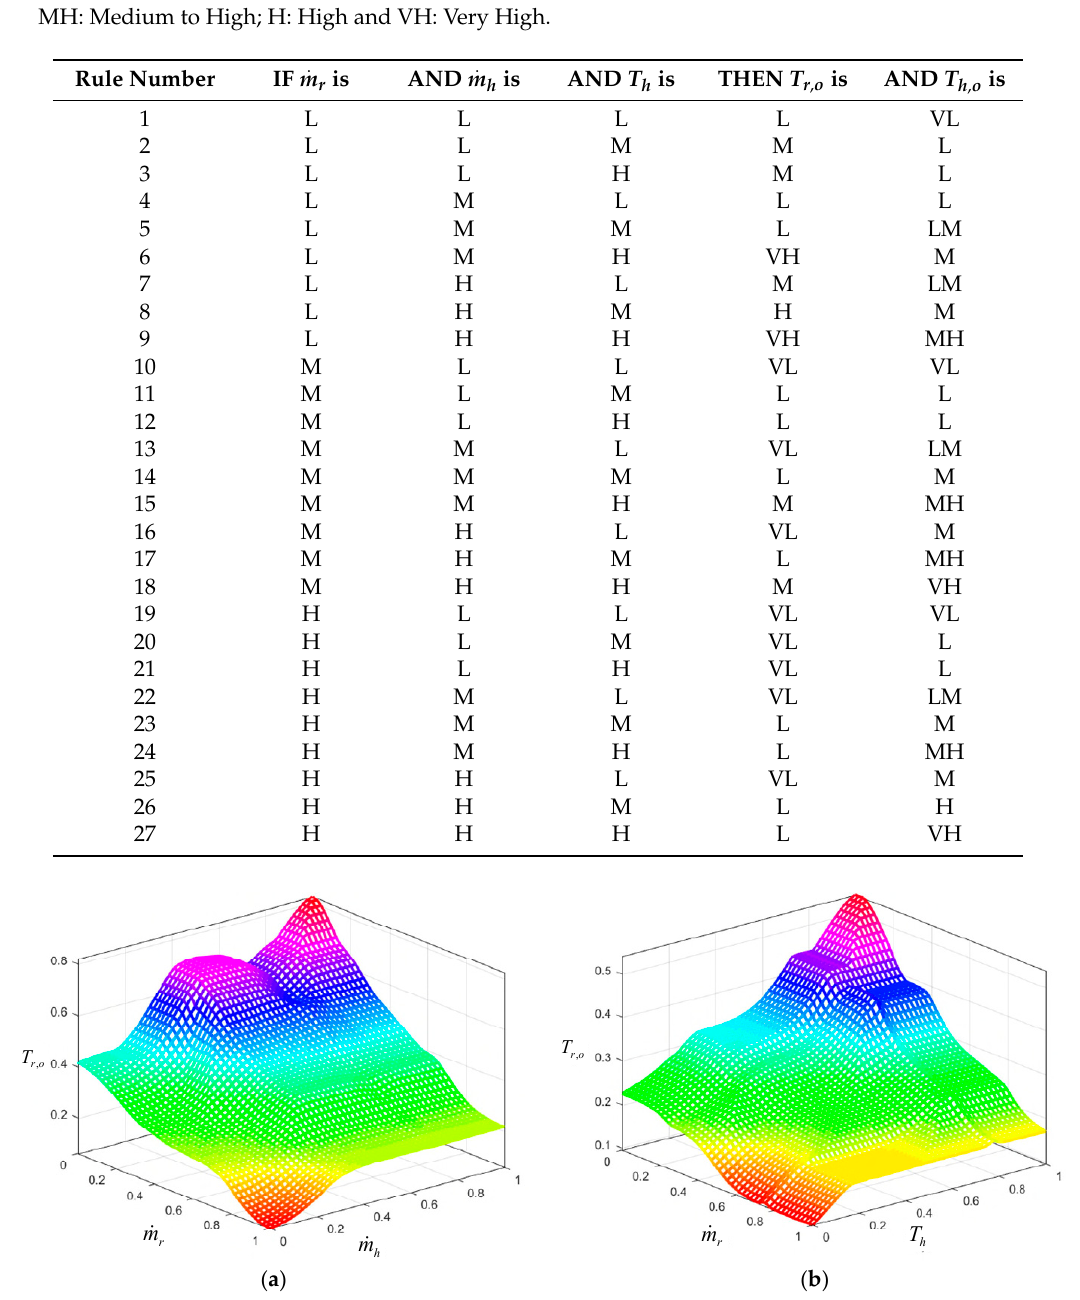
. . m h ( a ) m r and T h ( b r and